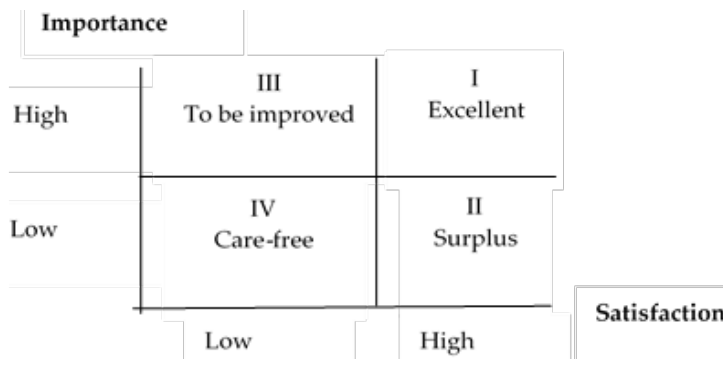
Figure 1. Importance – Satisfaction model [77].